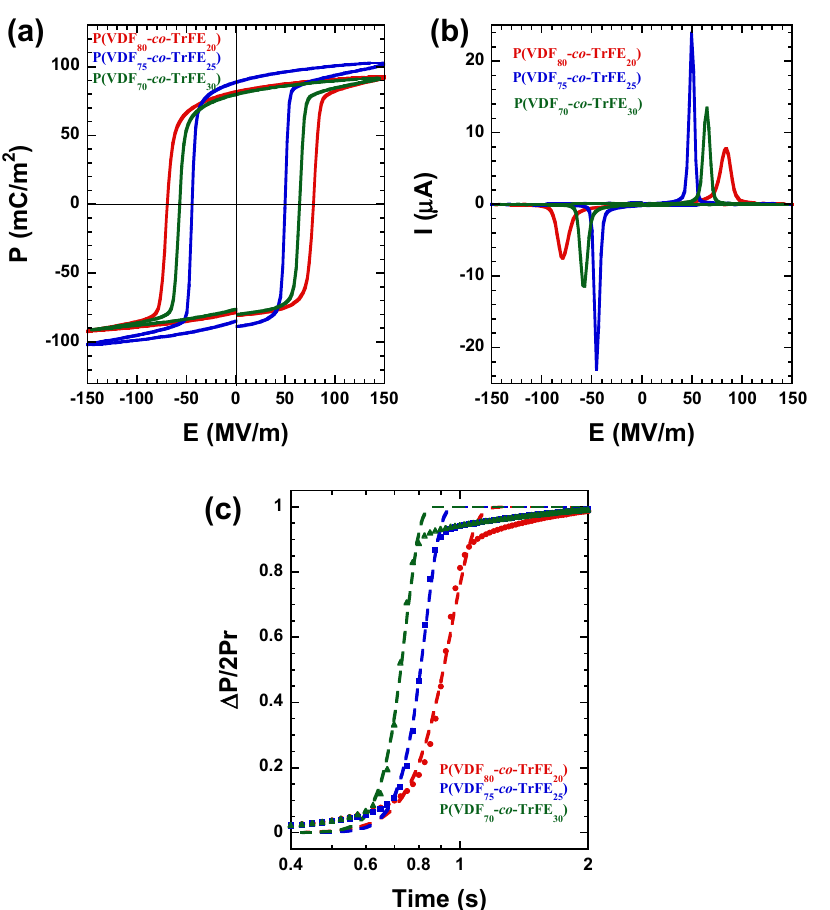
Figure 12. ( a ) Polarization vs. electric field hysteresis loop for the three P(VDF- co -TrFE) based compositions studied, ( b ) the corresponding current vs. electric field data, ( c ) switching transients of copolymers as a function of time at room temperature at a constant electric field of 150 MV/m, and dashed lines are the fits according to the KAI model.